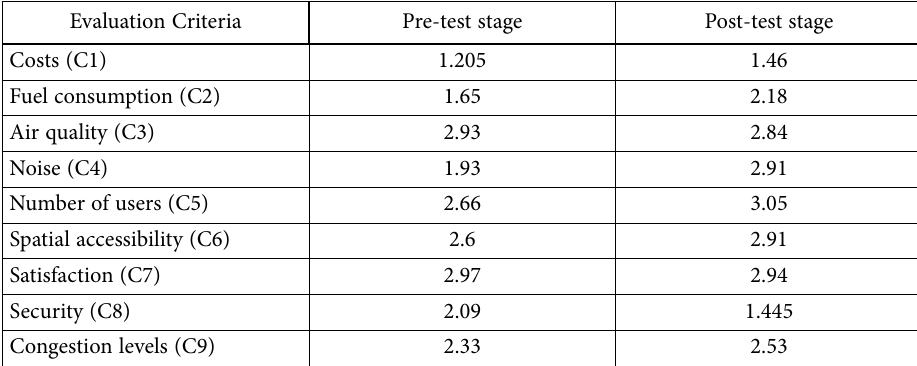
Table 5. Global utilities for